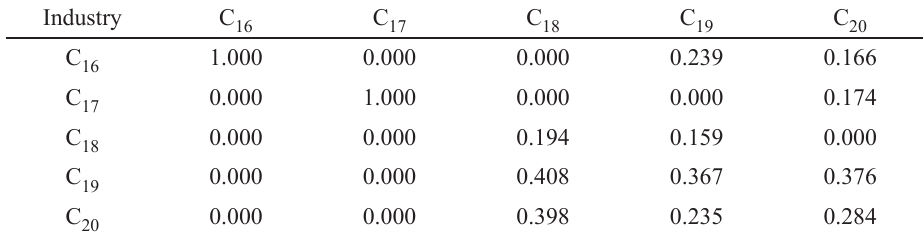
Table 10. The relative importance weights for criteria under the Industry Group Industry